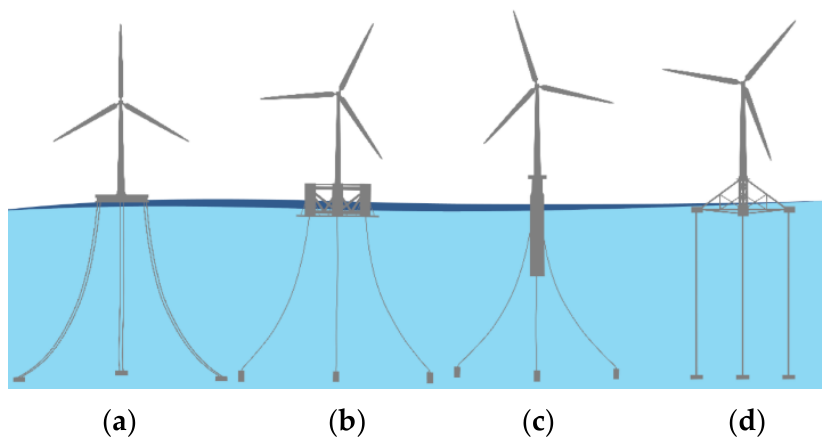
Figure 2. Various floating-type substructure types: ( a ) Barge; ( b ) semi-submersible; ( c ) spar; ( d ) tension leg platform (TLP) [24].